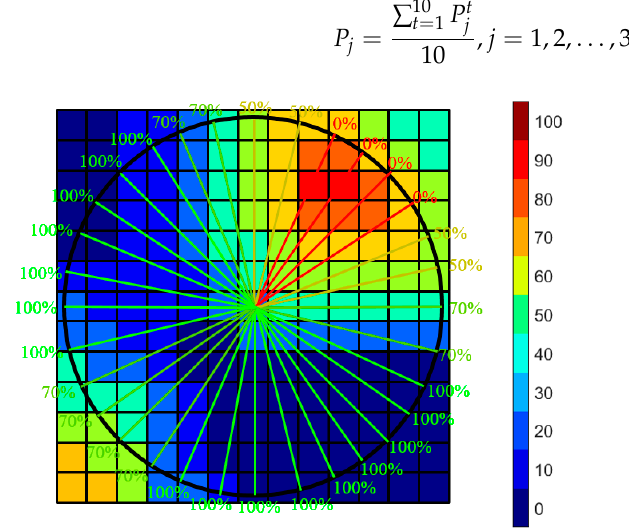
Figure 4. Schematic diagram of the penetration calculation.